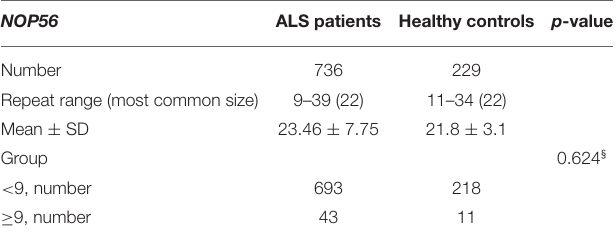
TABLE 5 | Analysis of GGCCTG repeats in the NOP56 gene in ALS patients and